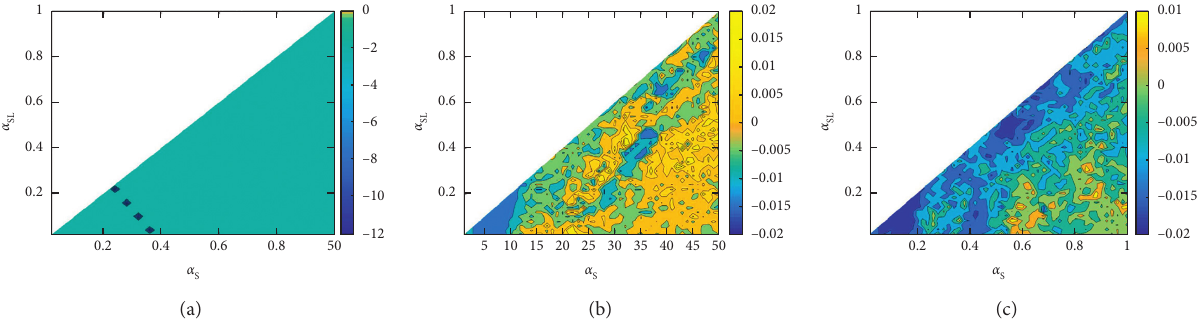
Figure 13: LLE diagram of supply chain nodes under the scenario of random demand obeying uniform distribution from the global � 6. (a) The retailer’s LLE chart. (b) The LLE chart of the distribution center. (c) The LLE chart of the perspective when G d � 3 and G 2 combined system from the decision